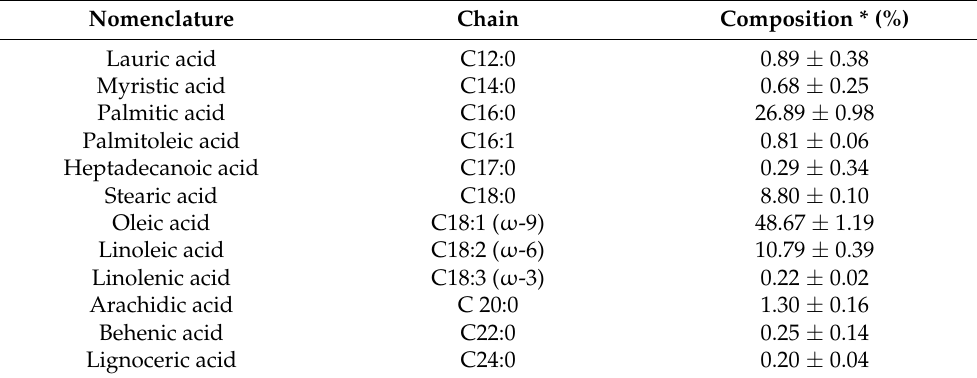
Table 3. Fatty acids composition of andiroba seed oil ( Carapa guianensis ) determined by gas chro-